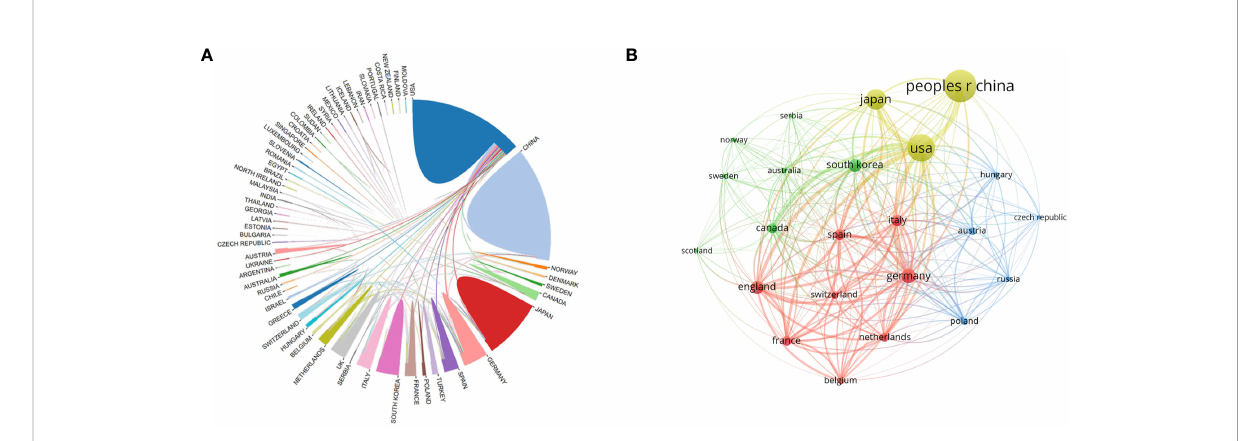
FIGURE 3 (A) The collaboration of countries. Each country is represented by a color block, and larger blocks indicate a higher number of publications. The line between the blocks represents the cooperation between countries. (B) Citation relationships between countries. China, the United States, and Japan are the major contributors to